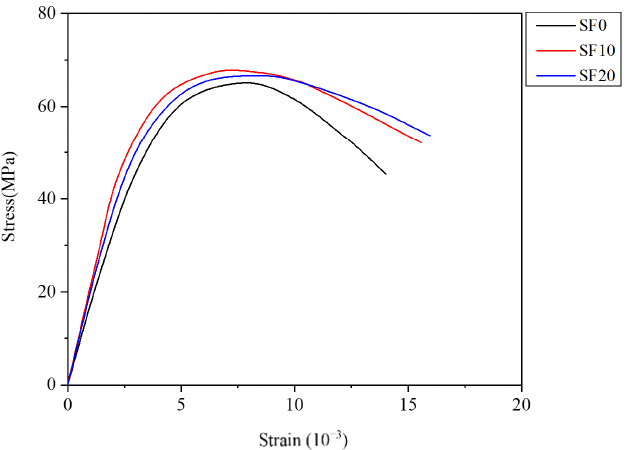
Figure 13. Stress – strain curve of different concrete specimens with 5MPa confining pressure and 10 −5 /s strain rate under 100 F – T